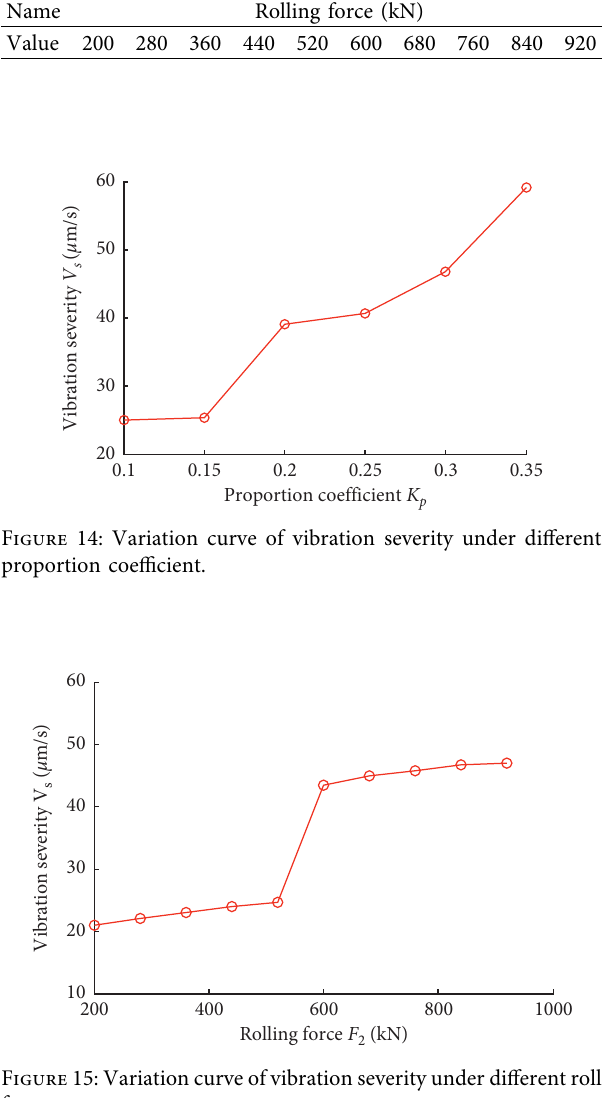
Table 2: Rolling force.